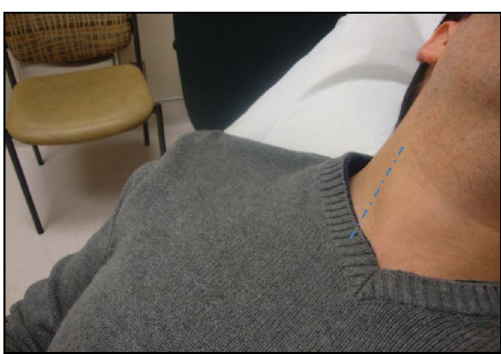
Figure 1. Assessment of Jugular Venous Pressure. The doted line displays the course of the internal jugular vein between the 2 heads of the sternocleidomastoid muscle.